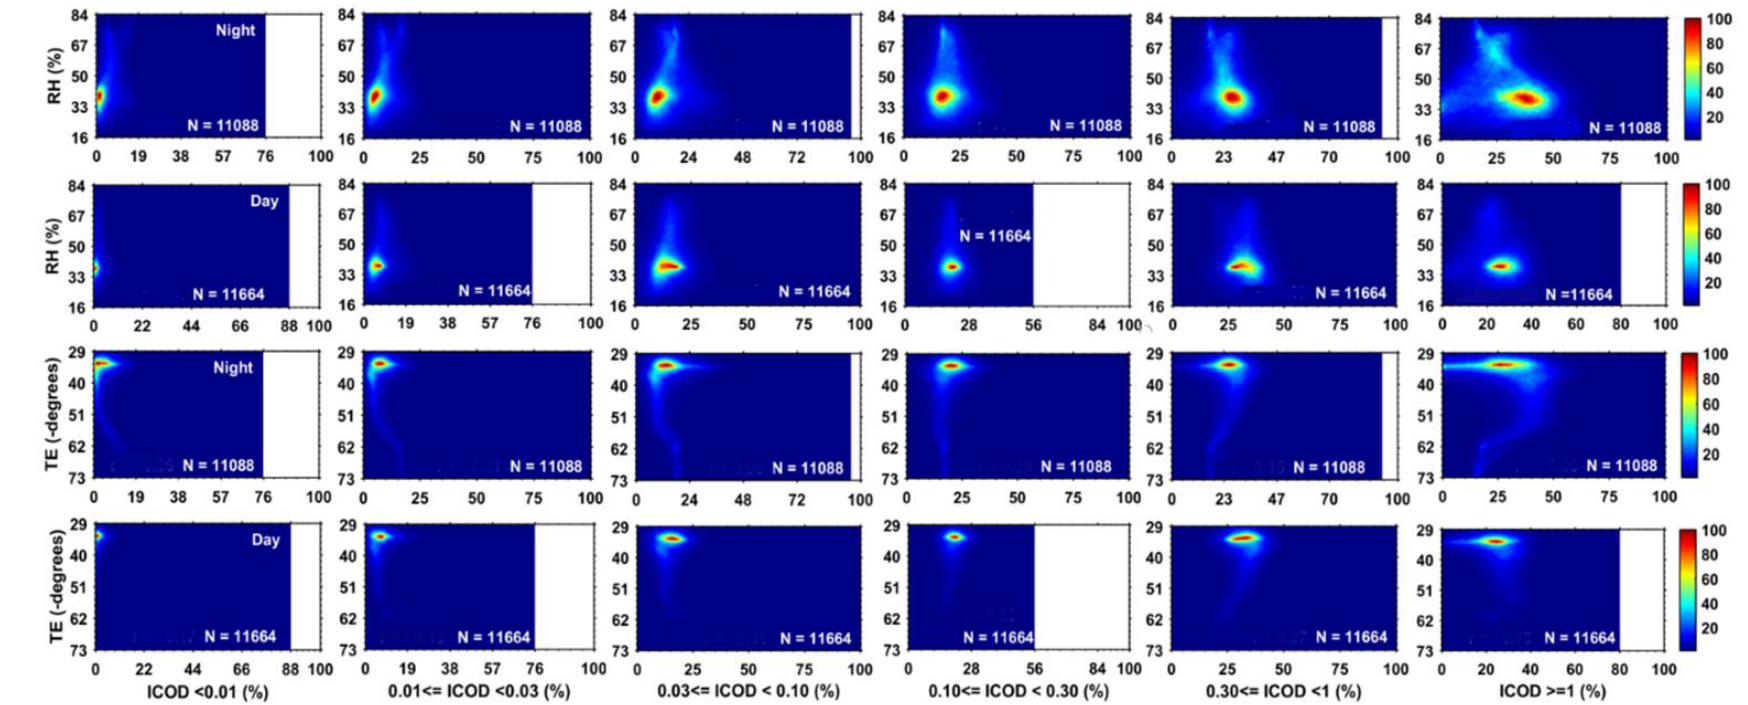
Figure 8. Relationships between occurrence frequency of different ICOD and average RH (first and second row) and TE (third and fourth row) during nighttime and daytime in the globe derived from the 10-year summertime measurements of CALIOP. The percentage (%) refers to the unit of ICOD on the x -axis. The color bar represents the density of data distributions, and the white colors show no data.